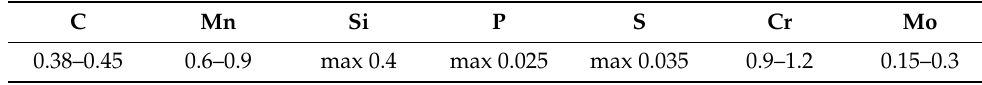
Table 2. Experimental test plan.